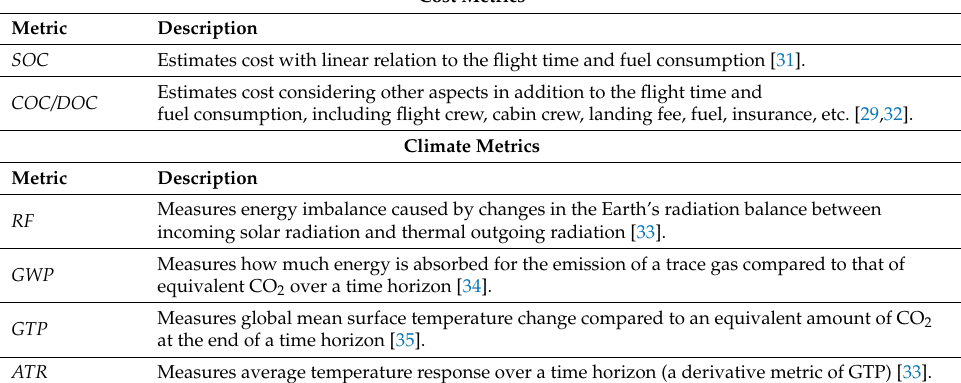
Table 1. Cost and climate metrics used in the literature for cost/climate optimal trajectory